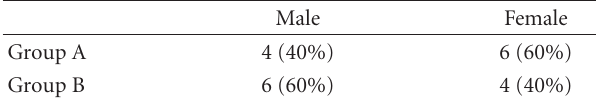
6 females (60%). Group B also consisted of 10 patients ( n = 10) and a gender distribution of 6 males (60%) and 4 females (40%). These data were presented in Figure 5 and Table 2.